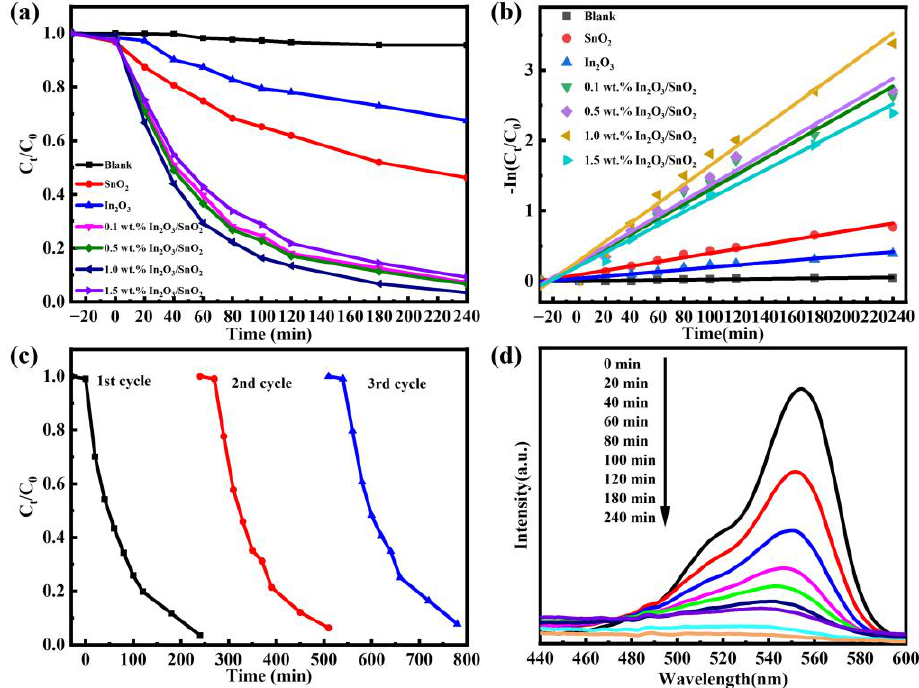
Figure 6. Photo-oxidation activity: ( a ) RhB variation curves; ( b ) degradation kinetics; ( c ) stability test; and ( d ) temporal evolution of UV–Vis spectra during decolorization of RhB.